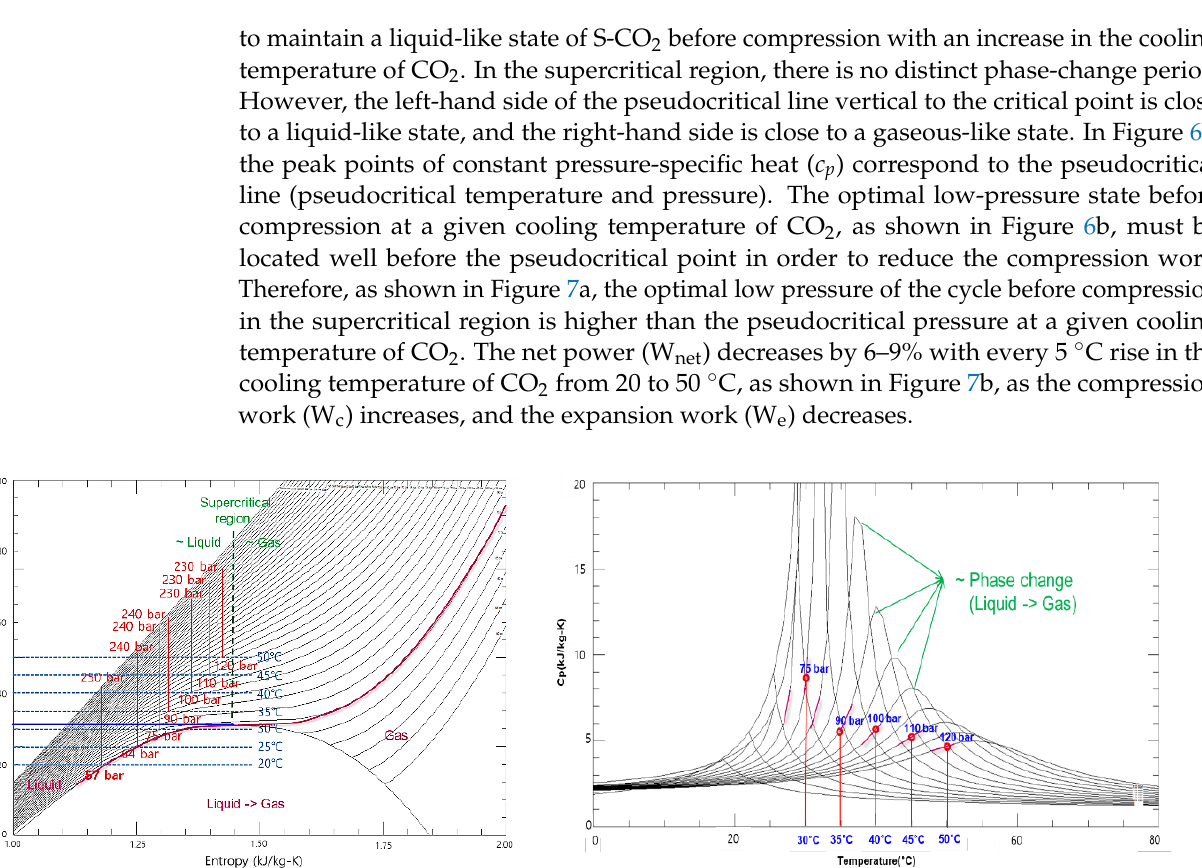
Figure 6. Optimal compression process of S-CO 2 power cycle for given cooling temperature: ( a ) T-s diagram; ( b ) constant specific heat (c p ) vs. temperature and low-pressure sides before compression.